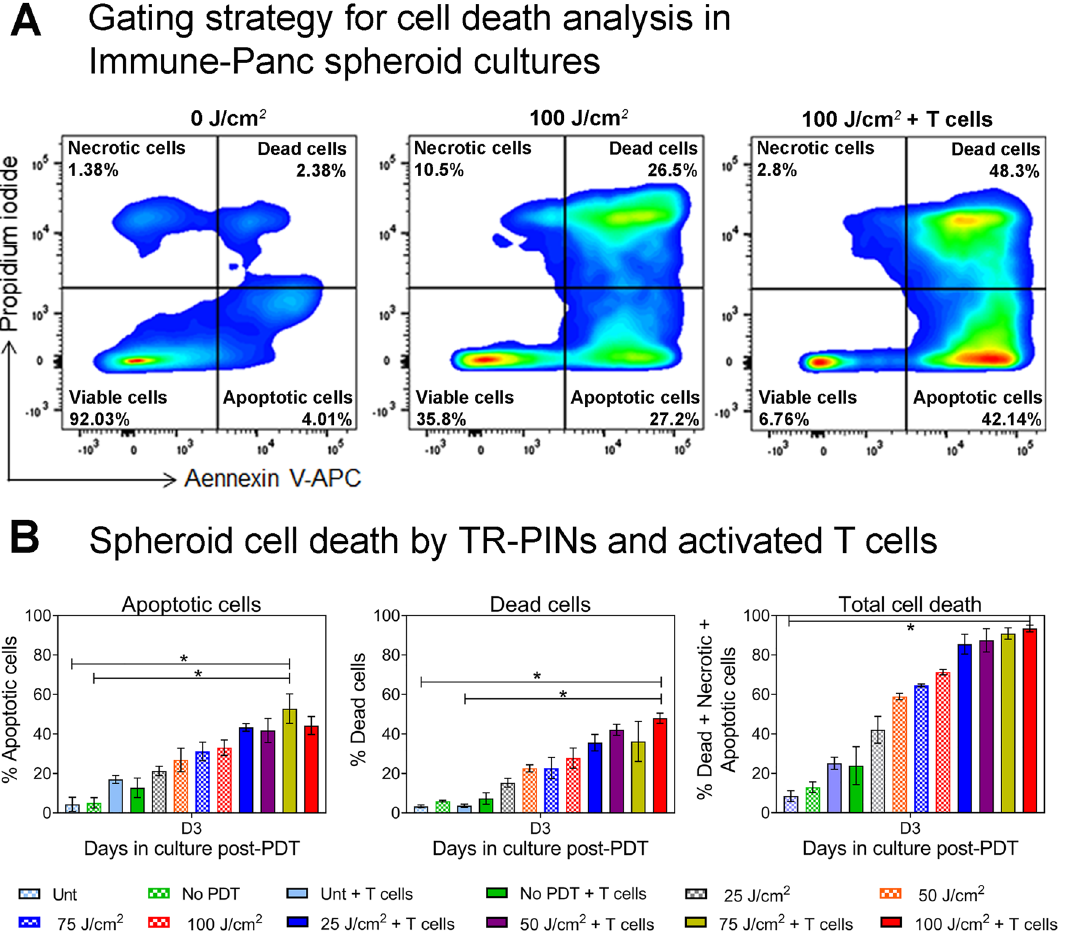
Figure 6: Synergistic effects on MIA PaCa-2 – PCAF cell killing by TR-PINs and antitumor reactive T cells. Analysis of cell death was performed using Annexin V and Propidium Iodide (PI) staining. (A) As shown in the gating strategy for cell death analysis, Panc spheroids were double-stained with Annexin V and PI and analyzed using flow cytometry. Four populations were identified as viablecells,apoptoticcells,deadcells,andnecroticcellsasindicatedintheflowcytometryplots.Quantificationofapoptoticcells,deadcells, andtotalcelldeath(sumofapoptoticanddeadcellsincludingnecroticcells)underdifferentcultureconditions,isshowninfigure(B).Dataare means ± SEM from three independent experiments done in duplicates. Statistical signi fi cance was determined by a one-way ANOVA and Tukey ’ s posthoc test. Asterisks denote statistical signi fi cance (* P < 0.05). The NIR photodynamic activation regimen used 690 nm light irradiation with 25 or 50 or 75 or 100 J/cm 2 at 150 mW/cm 2 . TR-PINs (BPD-PC equivalent) were used at a concentration of 250 nM. Key to